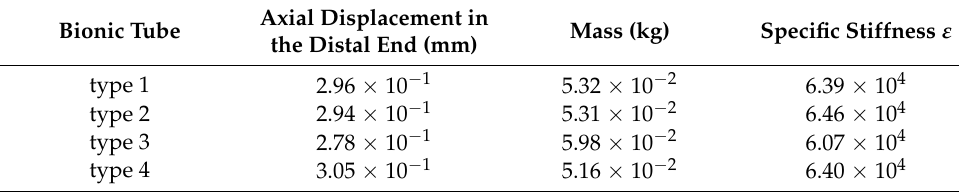
Table 2. Finite-element analysis of the bionic tubes.